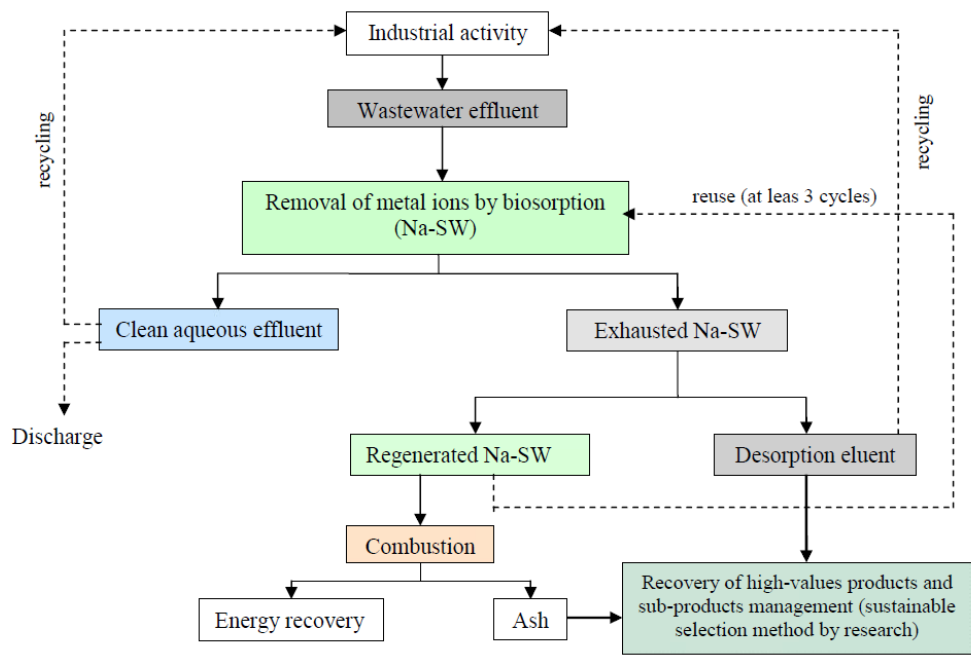
Figure 8. Pathways for the recovery of metals from exhausted biomass and effluent applied for the removal of heavy metals from wastewater using Na-SW biosorbent.